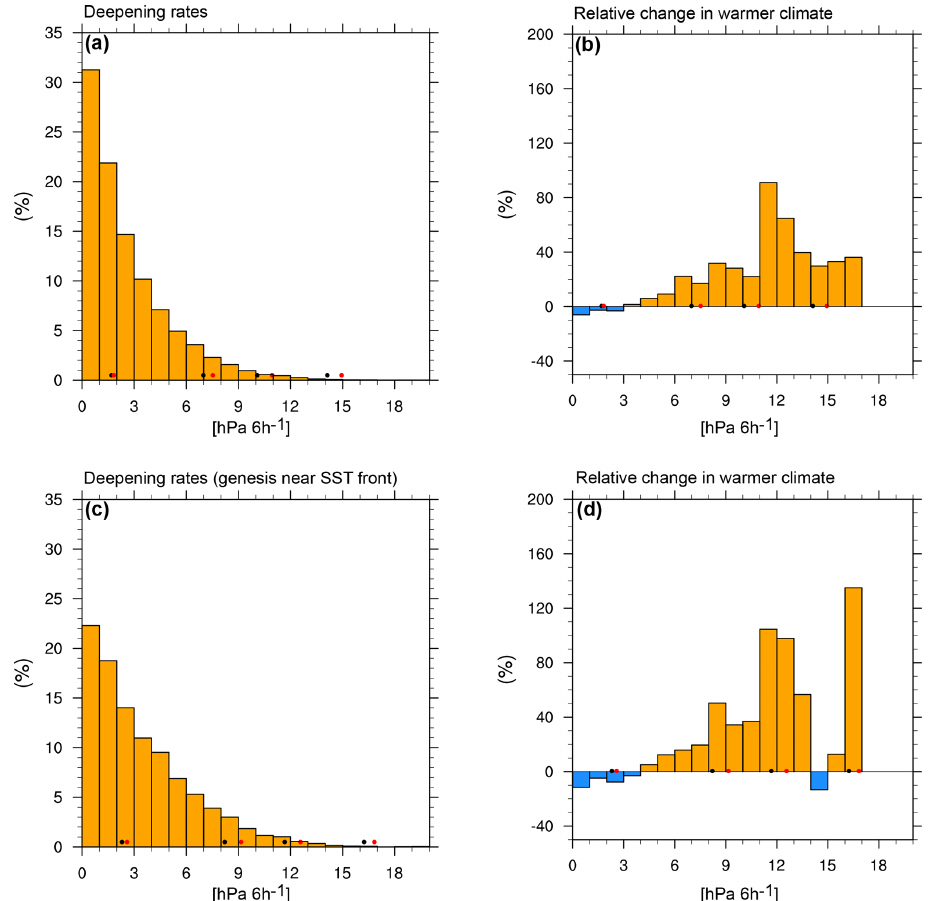
Figure 9. Frequency distribution of deepening rates, defined as 6-hourly minimum SLP changes, for (a) all cyclones and (c) cyclones with genesis in the vicinity of the SST front in the control simulation. On the lower axes, dots indicate the median and the 95th, the 99th, and the 99.9th percentiles for the control (black) and + 4K (red) simulations. (b, d) Relative change of the distributions shown in (a) and (c) in the + 4K simulation. Note that the large relative change for the high percentiles results from the low number of cases in these